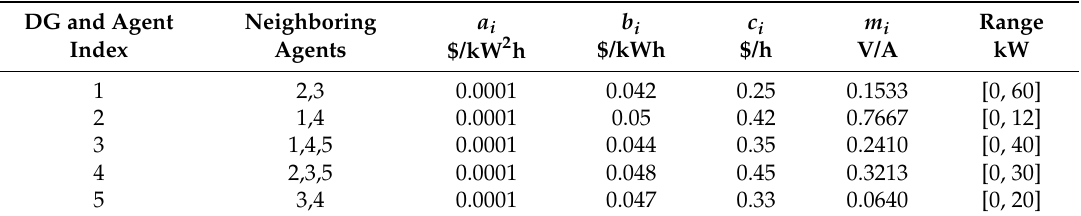
Table 1. Parameters of the DGs.